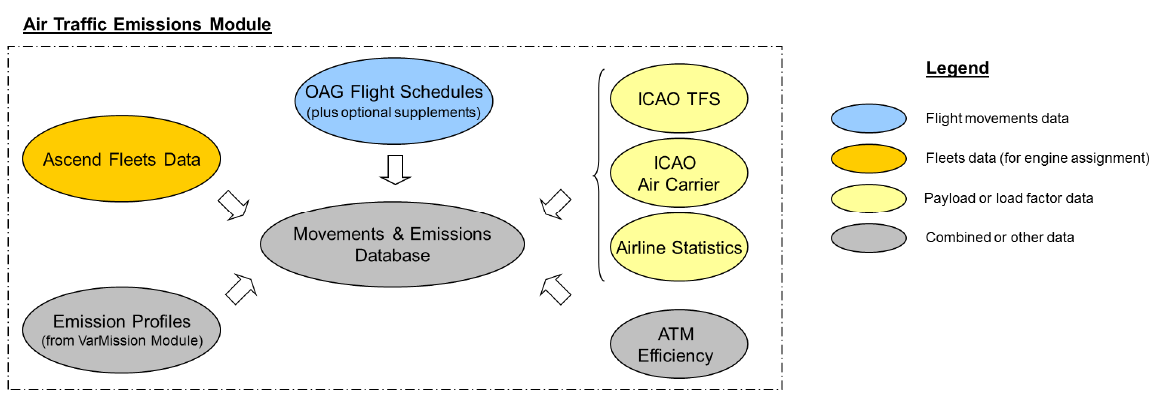
Figure 2. Schematic of the Air Traffic Module Source: Schaefer